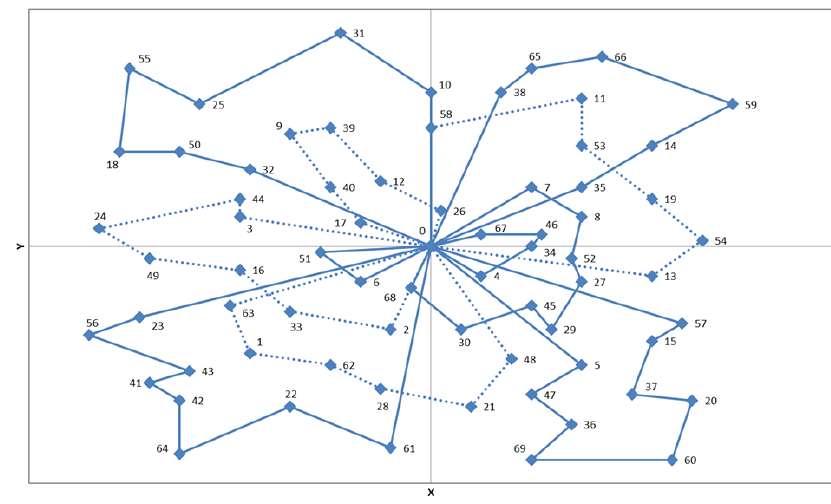
Fig. 6. Routes obtained considering fixed